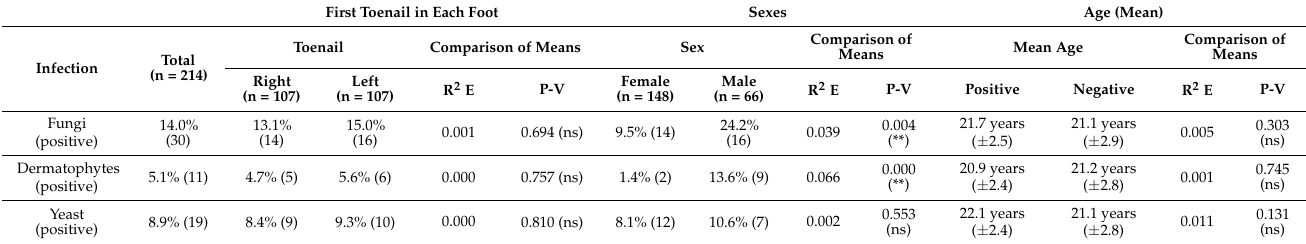
Table 1. Presence of infection. Comparison between first toenail for each foot, between sexes and relation to age